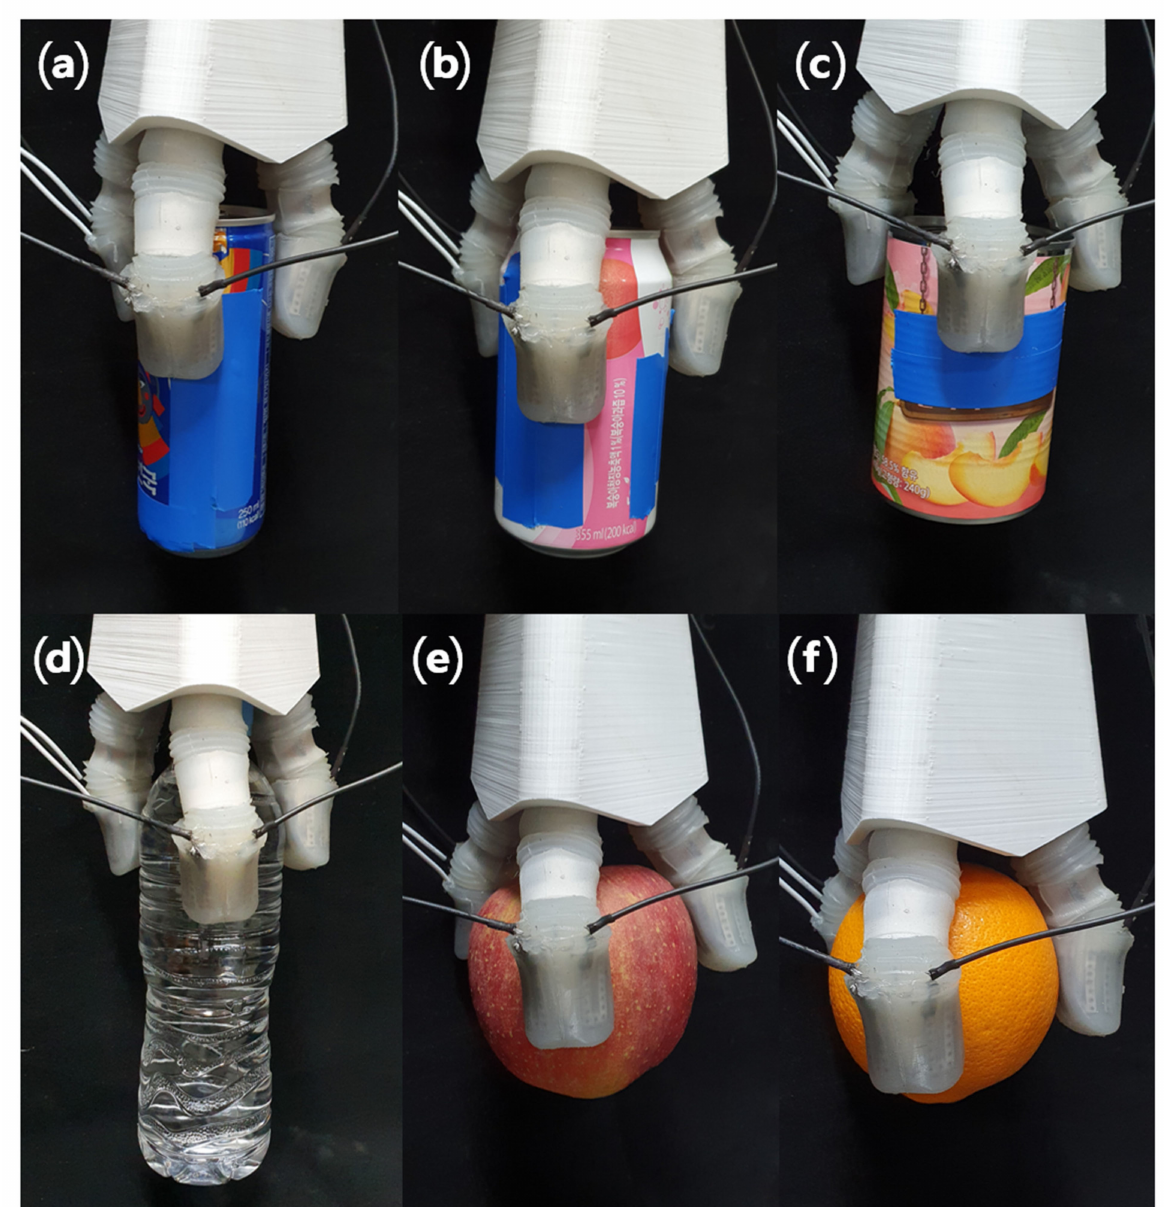
Figure 26. Images of prototype gripping for a range of targets: ( a ) 250 mL beverage can, ( b ) 355 mL beverage can, ( c ) 410 g can, ( d ) 500 mL bottle of water, ( e ) apple, ( f )